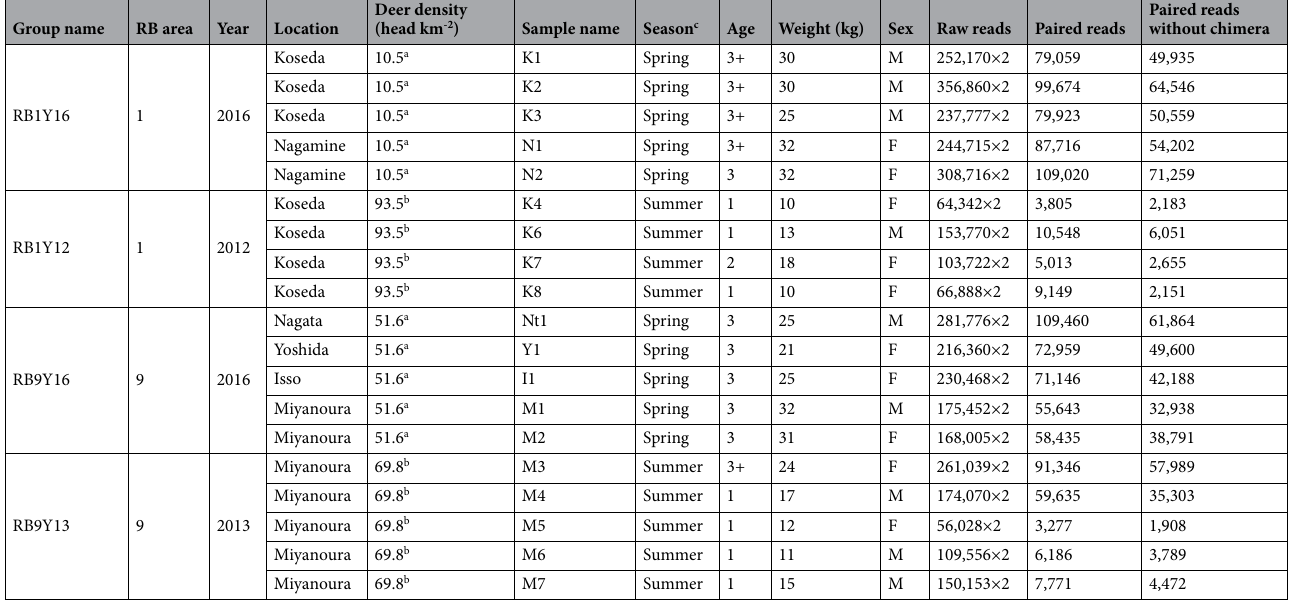
Table 1. Sample information and sequence summary. a Deer density was calculated as an average within the river boundary area 33 . b Deer density was calculated as an average within the location 34 . c Spring: April. Summer: June, July, and August.